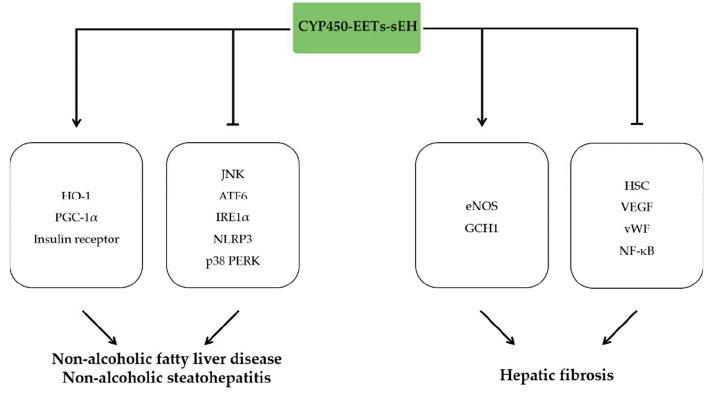
Figure 8. The anti-inflammatory effects of EETs in liver disease. EETs ameliorate non-alcoholic fatty liver disease and non-alcoholic steatohepatitis by activating HO-1, PGC-1α, and IR signaling pathways, reducing JNK, ATF6, and IRE1α expression and inhibiting NLRP3 and p38 PERK signaling pathways. EETs attenuate hepatic fibrosis by increasing eNOS and GCH1 and inhibiting HSC, VEDF, vWF, and NF-κB signaling pathways.